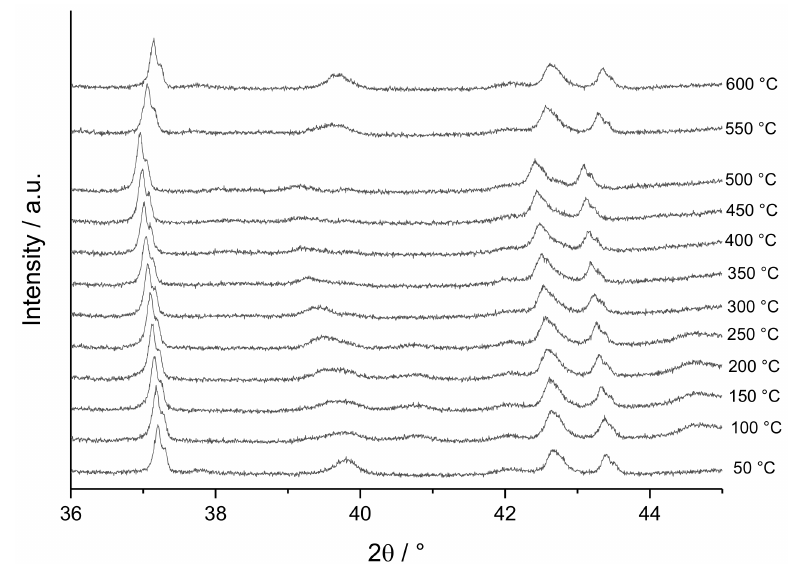
Figure 5. Temperature-programmed XRD analysis of